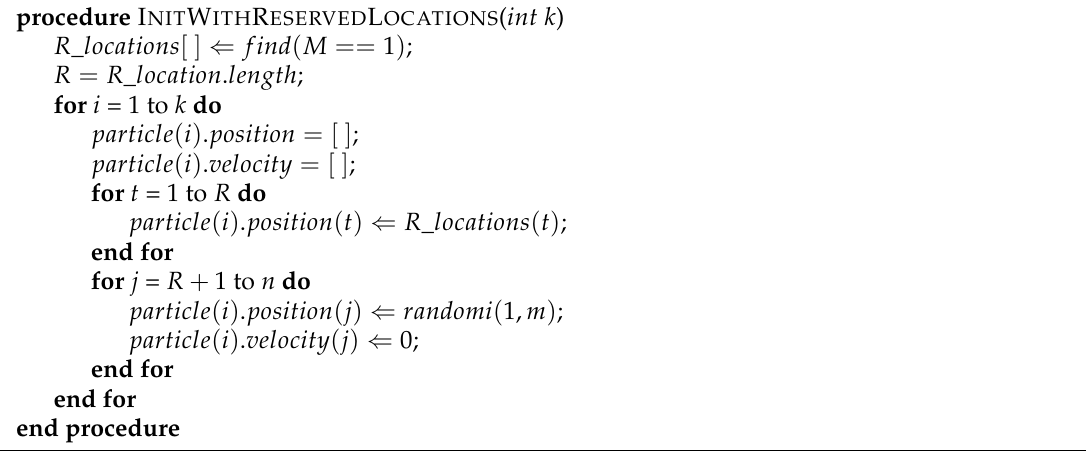
Algorithm A4 Pseudocode of MODPSO initialization with reserved locations